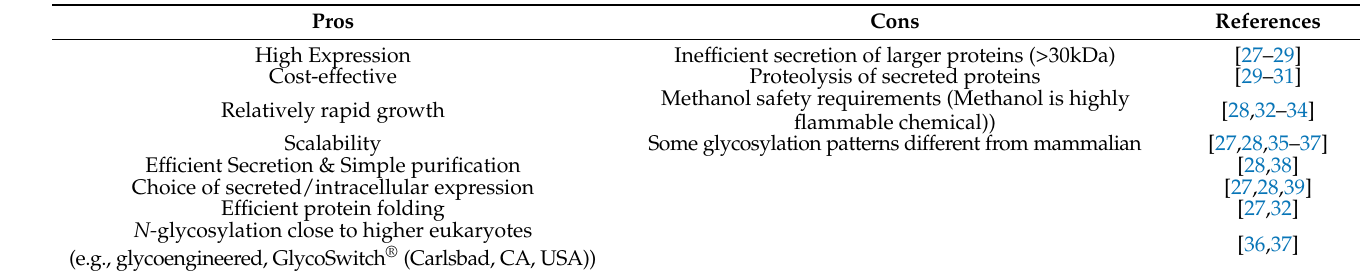
Table 4. Pros and Cons of using P. pastoris as an expression